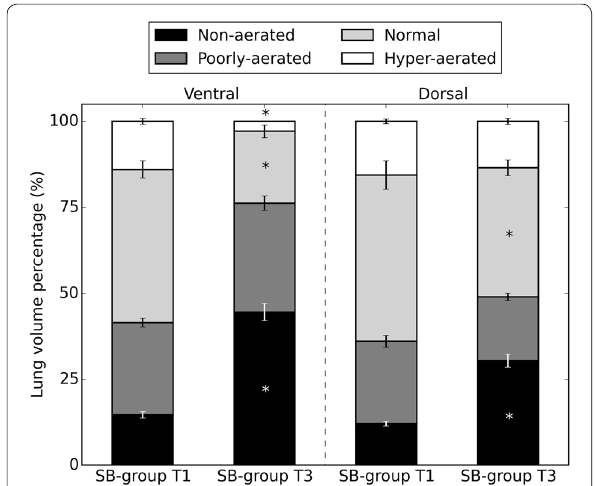
Fig. 1 Distribution of non‑aerated, poorly aerated, normal aerated and hyper‑aerated lung, as defined by micro‑CT scans of the total lung at end‑of‑expiration lung volume for SB‑group and MV‑group at times T1 and